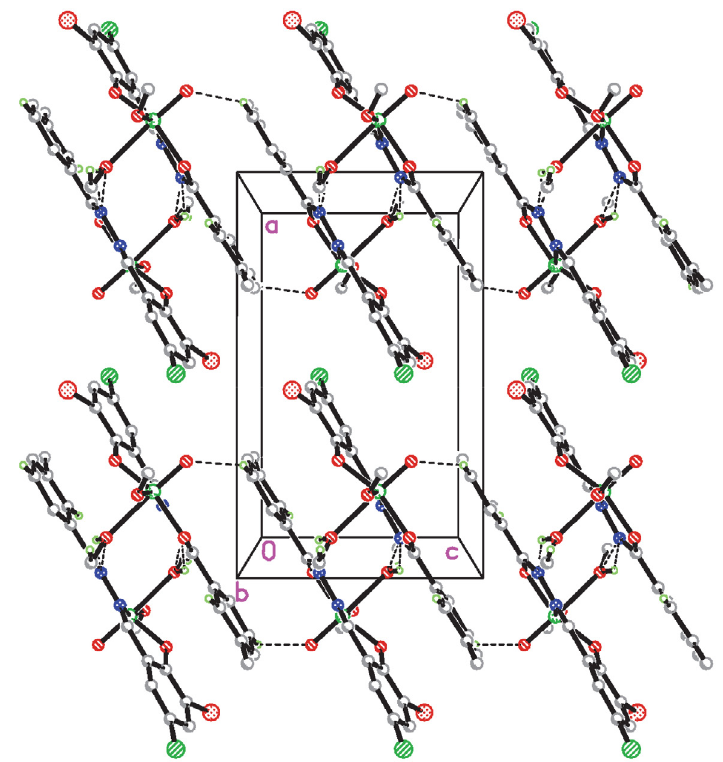
Figure 6. Molecular packing structure of complex 2 , with hydrogen bonds shown as dotted